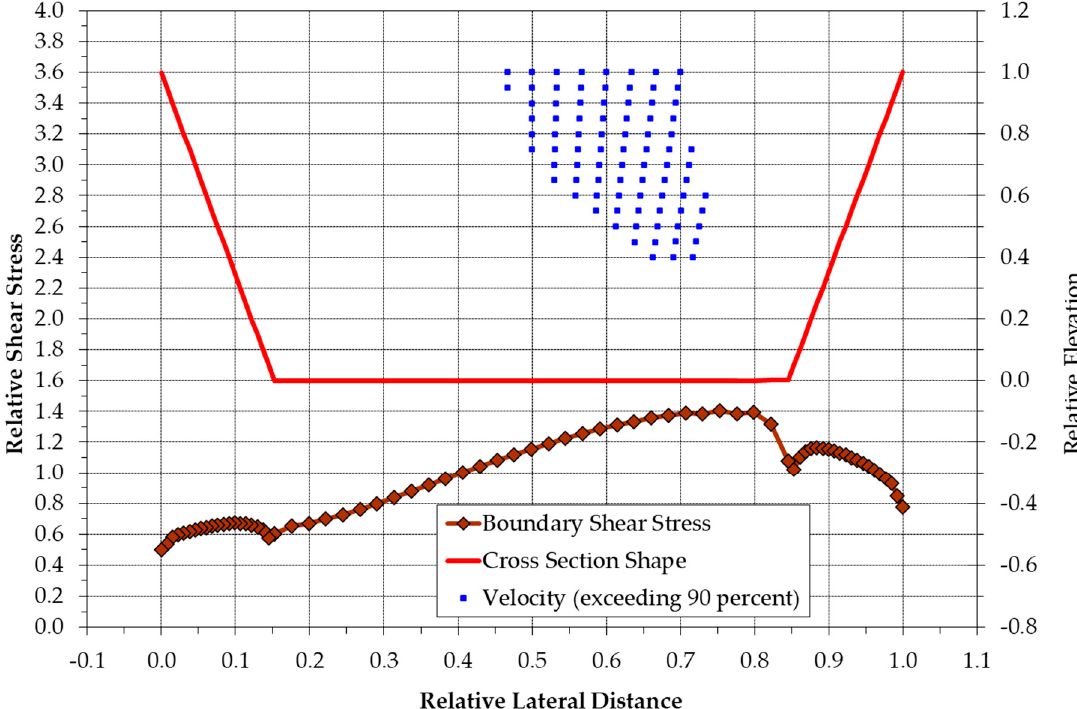
Figure 34. Cross-section 702 (3rd meander bend) lateral distribution of shear stress and zone where velocity is at least 90 percent of the maximum velocity.